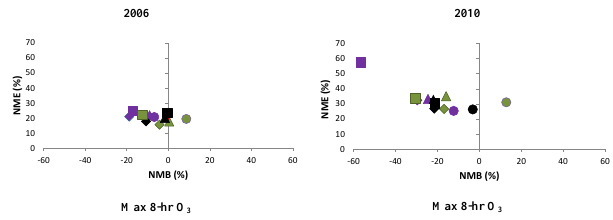
Figure 3. Comparison of seasonal plots of NMB vs. NME for max- imum 8h O 3 concentrations where the different shapes represent different seasons (diamond – MAM, circle – JJA, triangle – SON and square – JFD) and the different colors represent different ob- servational data (purple – CASTNET, black – AQS and green –